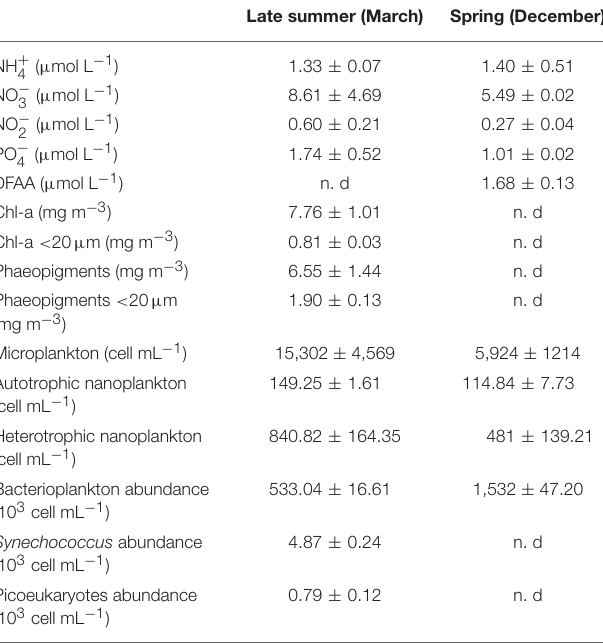
TABLE 1 | Initial nutrient concentration, dissolved free amino acid (DFAA) concentration, photosynthetic pigments, and the abundances of nanoplankton, microphytoplankton, bacterioplankton, cyanobacteria, and picoeukaryotes s in late summer and spring (mean ± standard